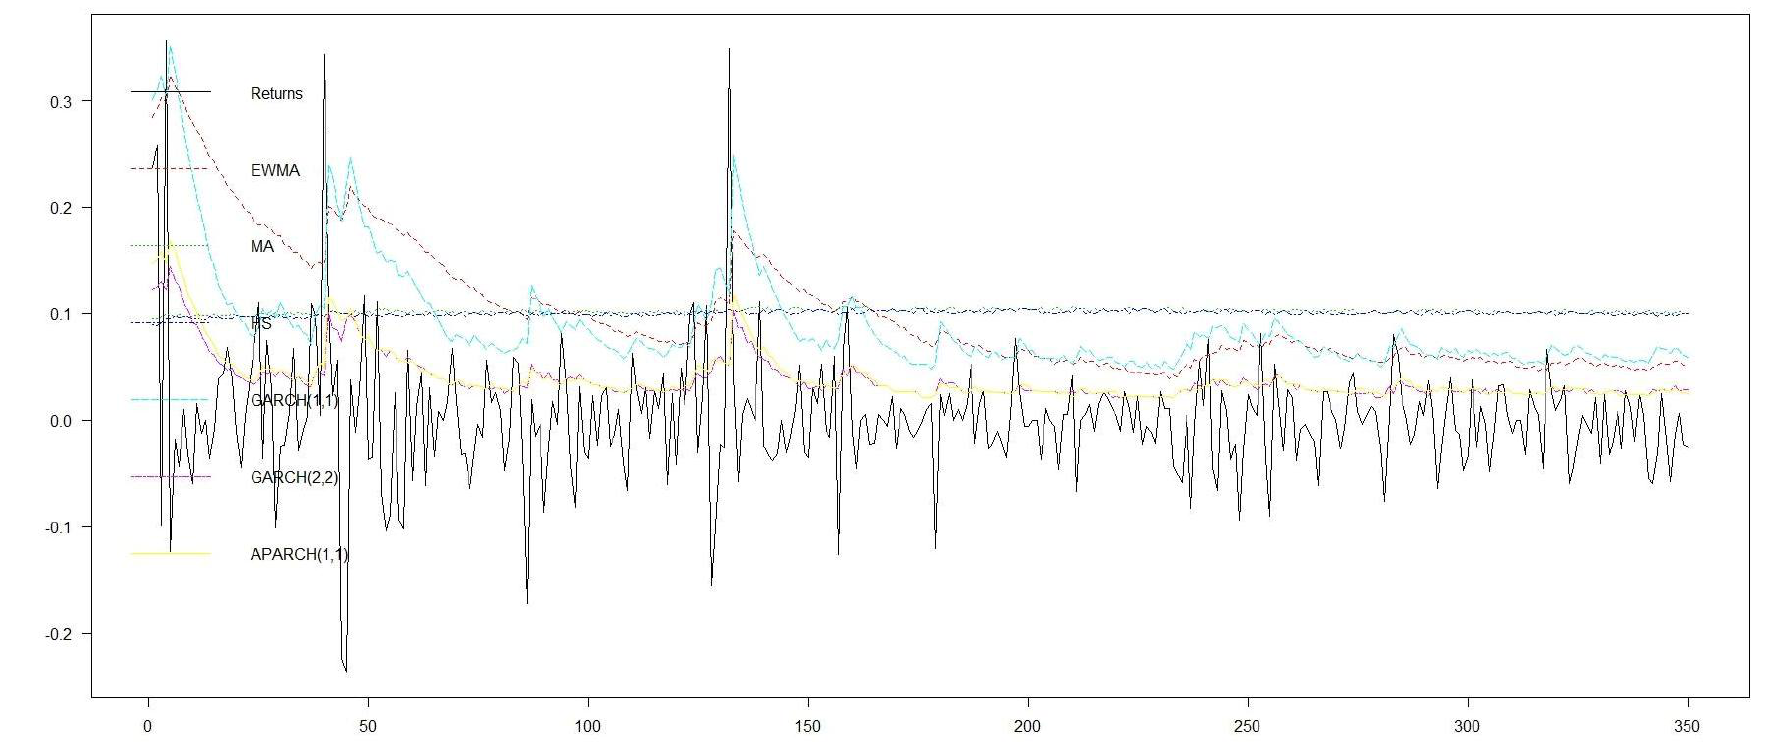
Figure 9. Backtesting with low price